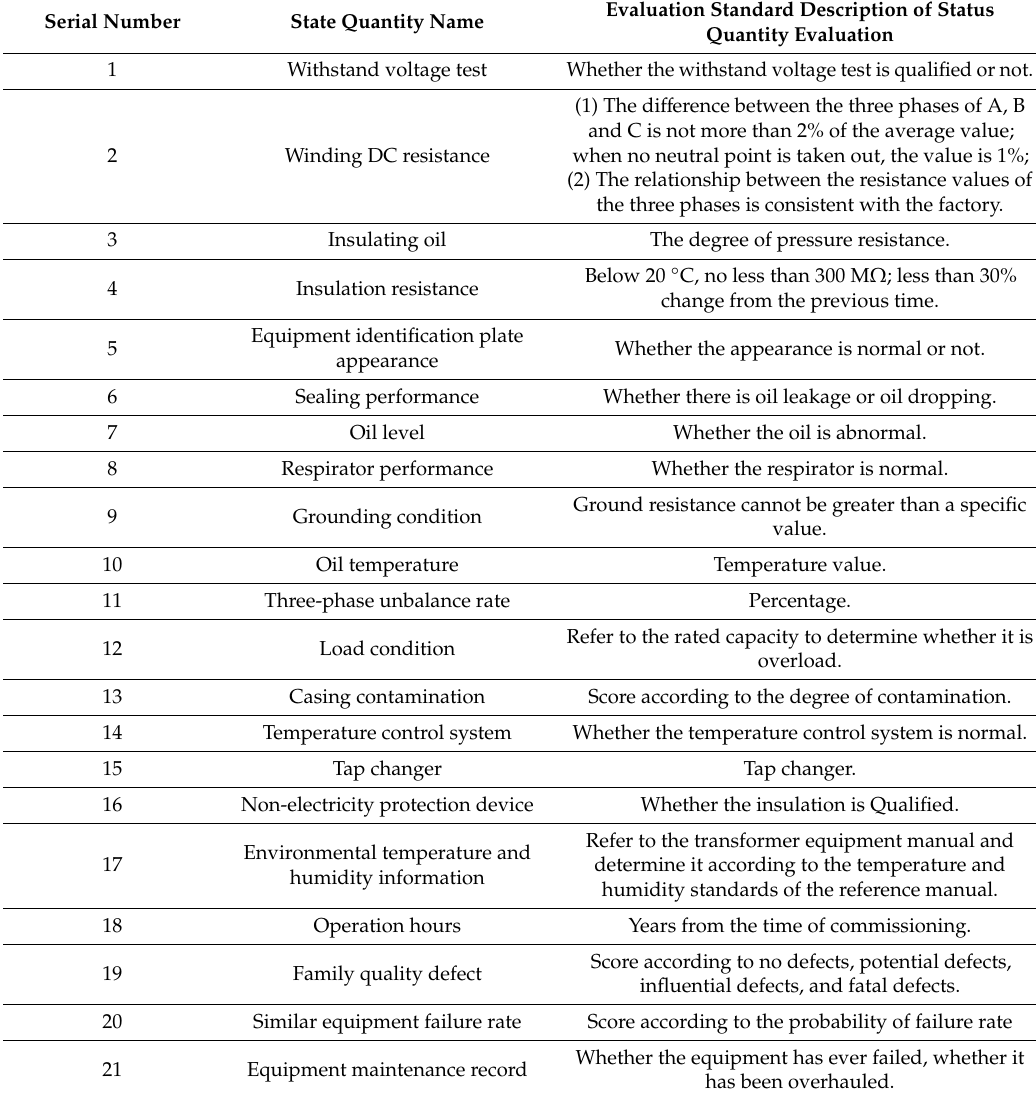
Table 3. Grading standard for distribution transformer